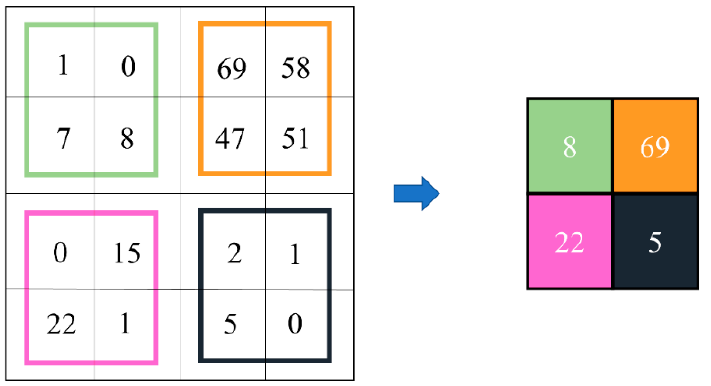
Figure 10. Maximum pooling operation for 4 × 4 feature map by 2 × 2 kernel with stride = 2.